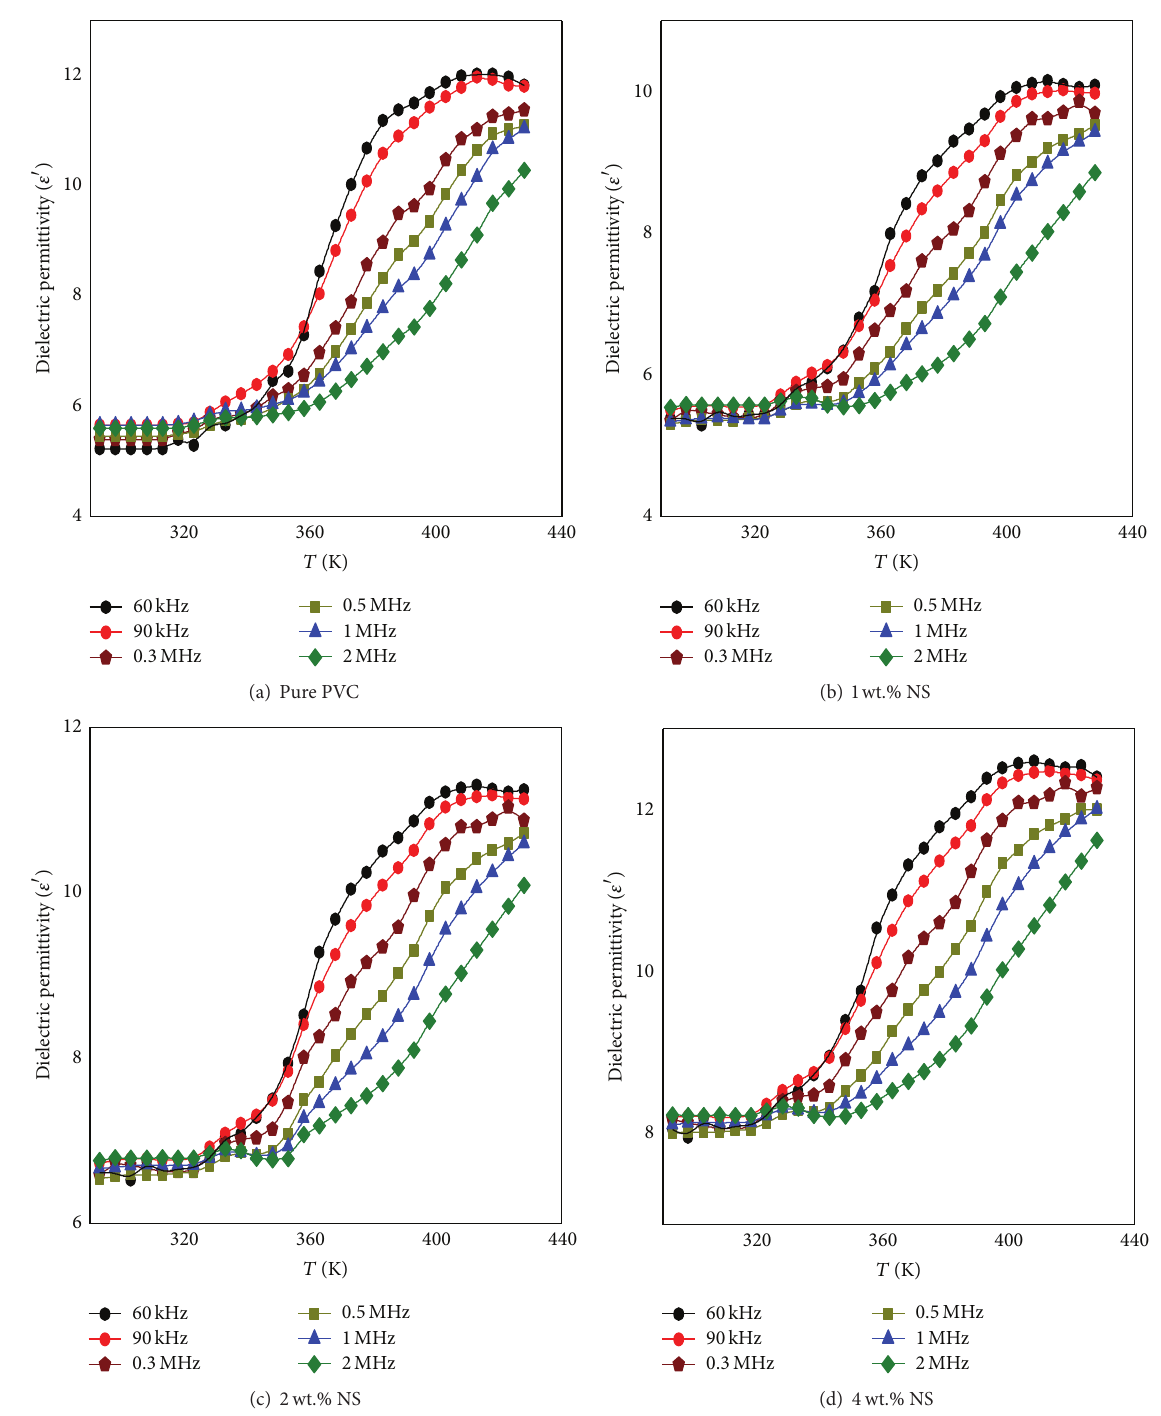
Figure 9: The variation of dielectric constant 𝜀 󸀠 as a function of temperature for pure PVC and PVC-SiO 2 nanocomposite films with different concentrations at different